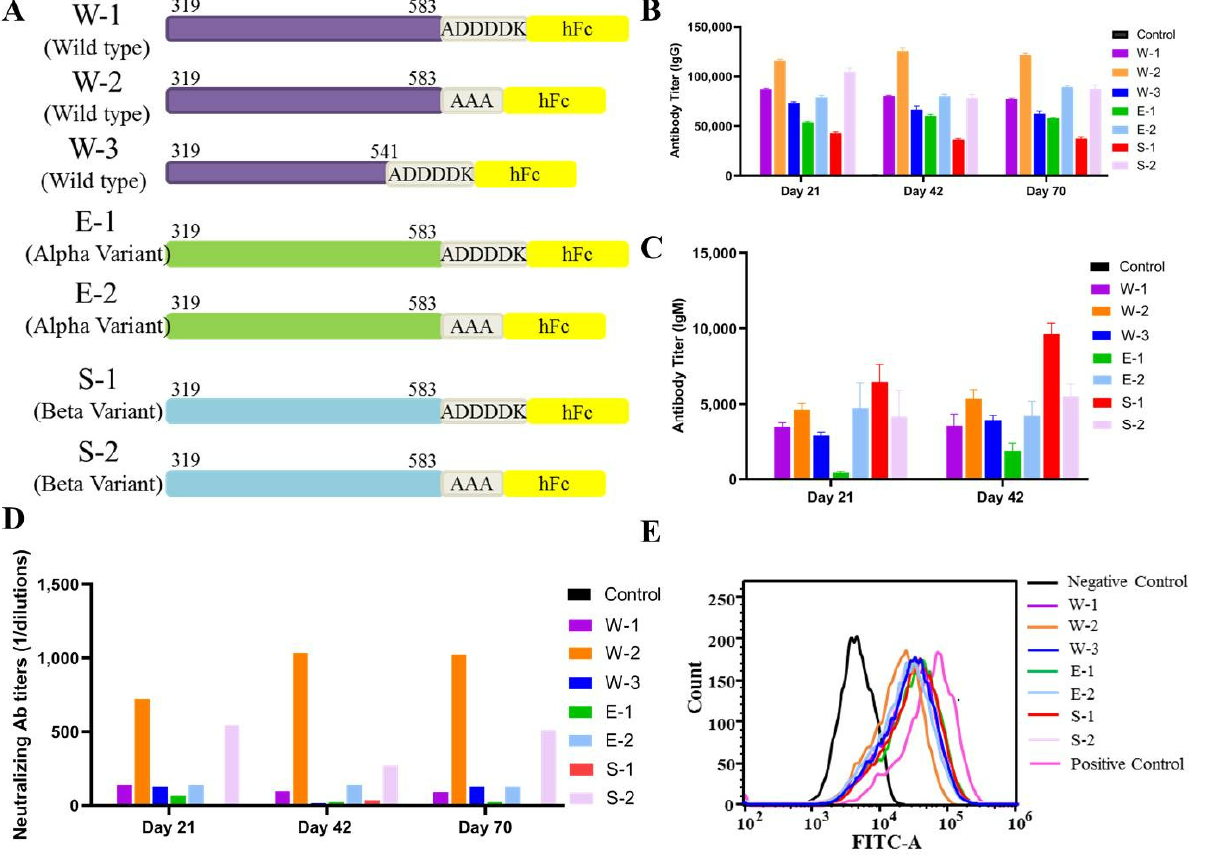
Figure 5. Evaluation of linker size on immunogenicity. ( A ) Expression vector sequence containing SARS-CoV-2 wild-type, Alpha and Beta RBD sequence fused to hFc with a larger or small linker. ( B ) IgG titers in mouse sera were determined by ELISA. ( C ) Serum levels of IgM titer on days 21 and 42 were determined by ELISA. ( D ) Neutralizing activity in response to the SARS-CoV-2, alpha or beta variants, challenge. ( E ) Flow cytometry shows inhibition of recombinant protein binding to ACE2.